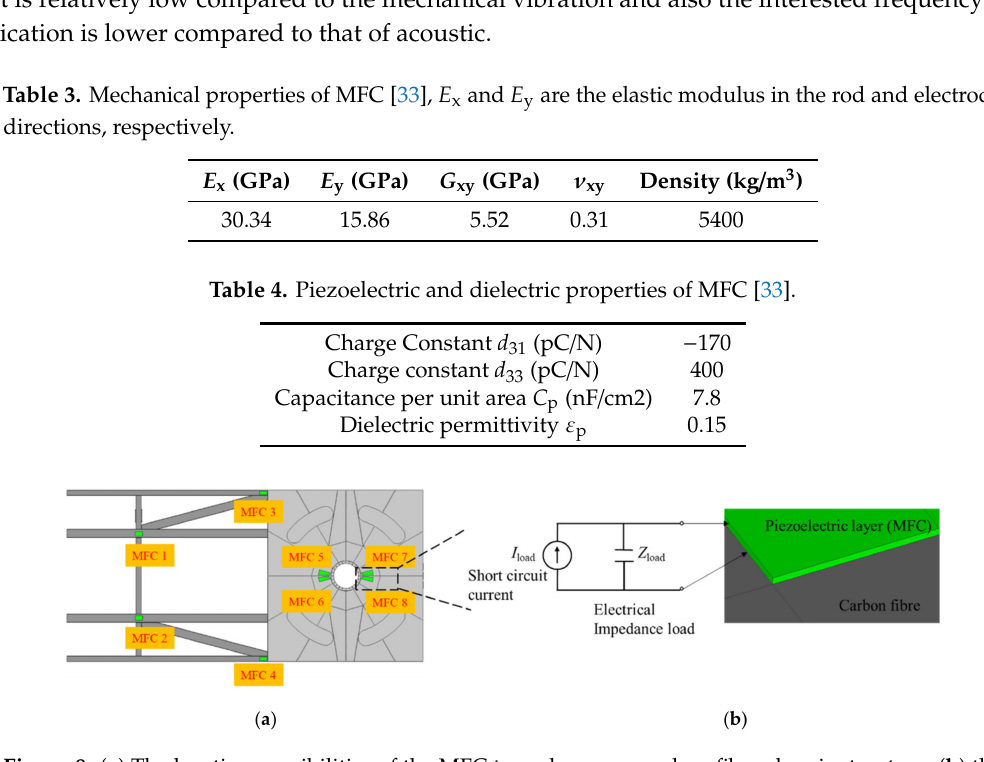
Figure 8. ( a ) The location possibilities of the MFC transducers on carbon fiber chassis structure, ( b ) the principle of the MFC transducer used to generate electrical power based on an electrical load, Z load